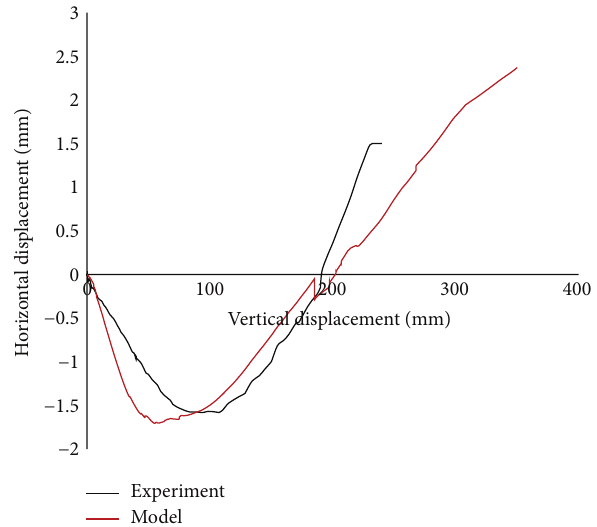
Figure 20: Horizontal displacement of end columns versus vertical displacement of center column.